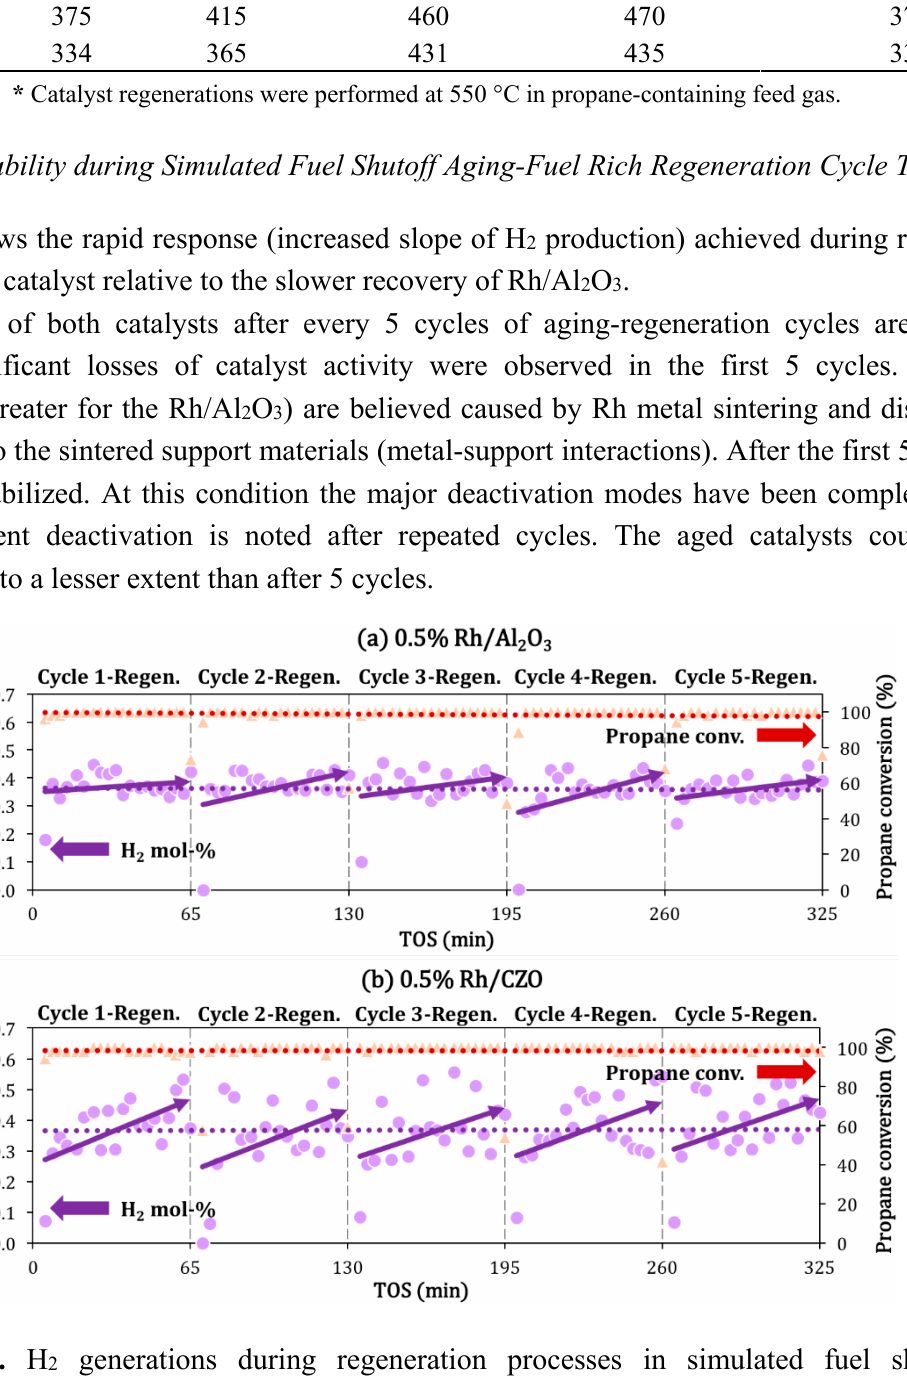
Figure 8. H 2 generations during regeneration processes in simulated fuel shutoff aging- fuel rich regeneration cycle tests (First 5 cycles out of total 25 cycles) with ( a ) 0.5% Rh/Al 2 O 3 and ( b ) 0.5% Rh/CZO. In each cycle, the catalyst sample was first aged in air at 1050 °C for 5 min, followed by in situ regeneration at propane rich condition at 550 °C for 1